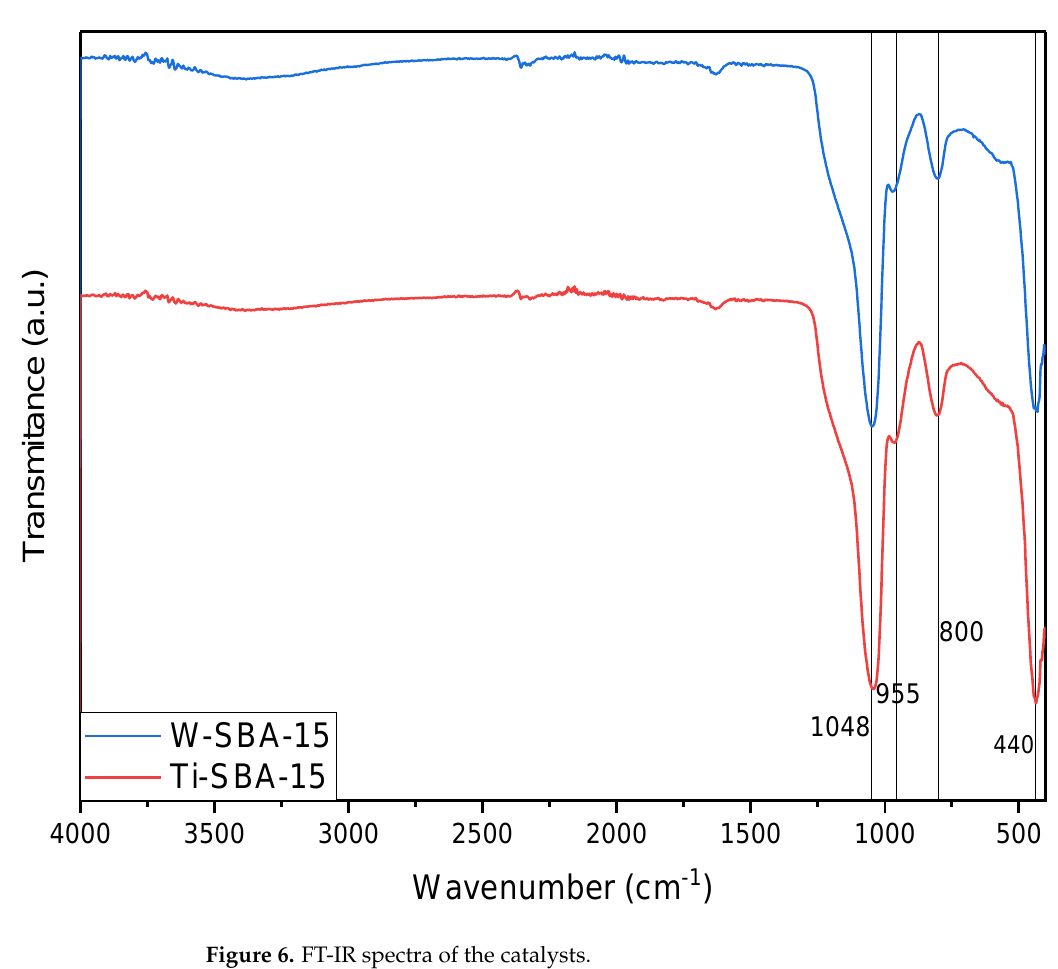
Figure 7. Graphs showing conversion of CDT ( left ), selectivity of transformation of CDT to ECDD ( right , main), and ECDD yield in relation to CDT ( right , insert) with different catalysts and catalyst contents. Reaction conditions: temperature, 60 °C; solvent, i-PrOH, 90 wt%; CDT:H 2 O 2 (60 wt% aqueous solution) molar ratio, 2.